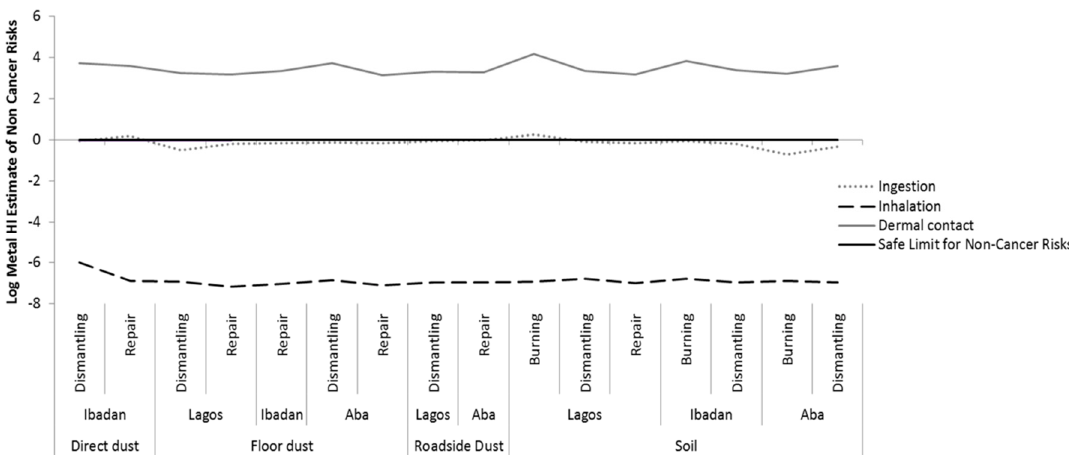
Figure 3. Hazard index (HI) for non-cancer risk of metal exposure via ingestion, inhalation, and dermal contact of soil and dust at various e -waste sites in the three locations, showing that e -waste workers are prone to non-cancer risks via dermal contact with metals in soils and dust, also via the ingestion of top soils at burning sites in Lagos.